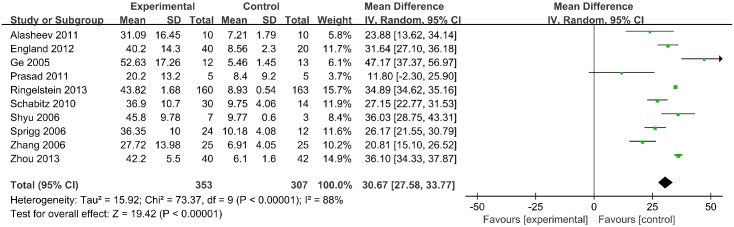
Leukocyte counts.